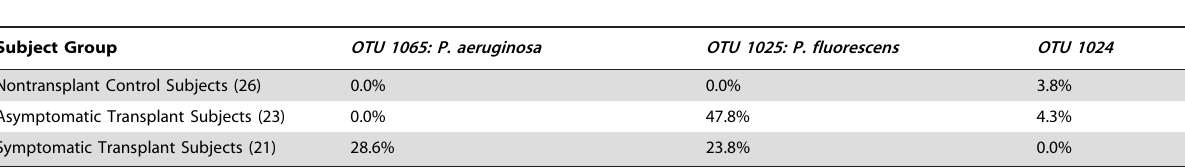
Table 6. Percentage of Subjects with . 10% Relative Abundance of Prominent Pseudomonas